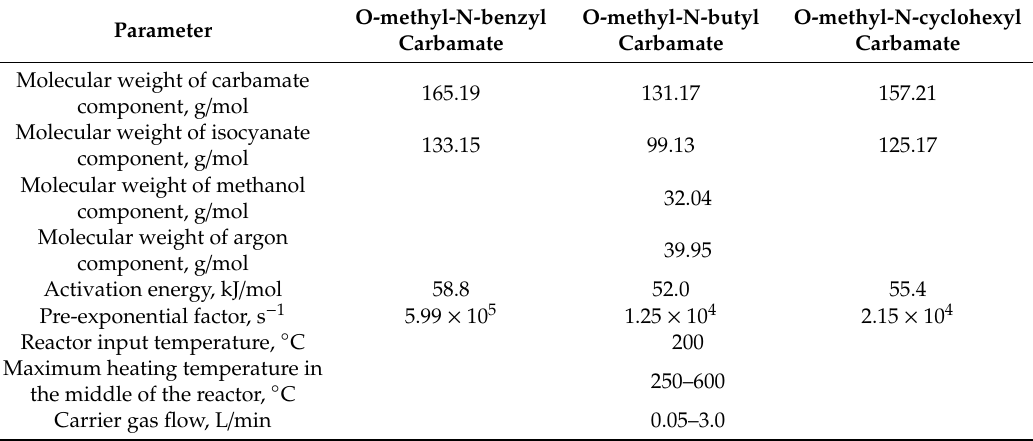
Table 8. Input parameters for the computational experiments.